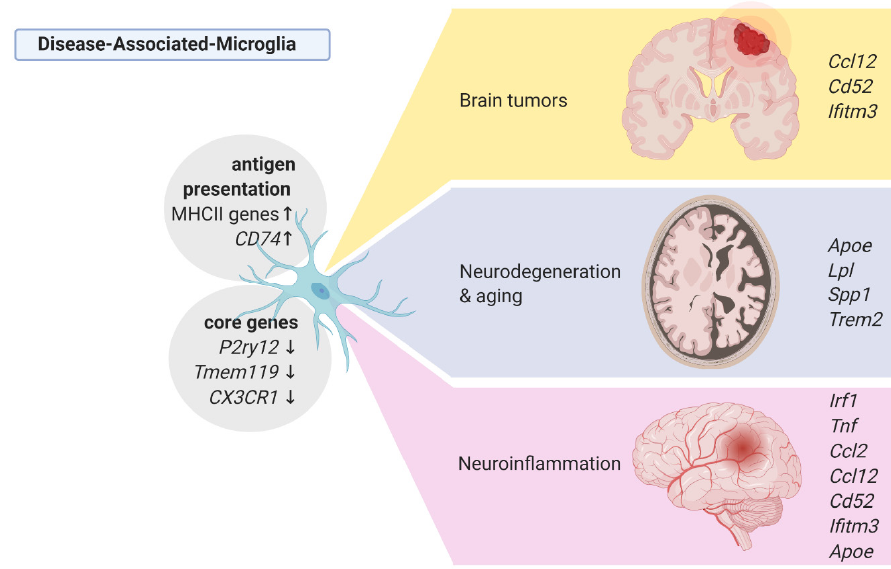
Figure 2. Phenotypes of the disease-associated microglia from single-cell studies. Created with BioRender.com (accessed on 8 March